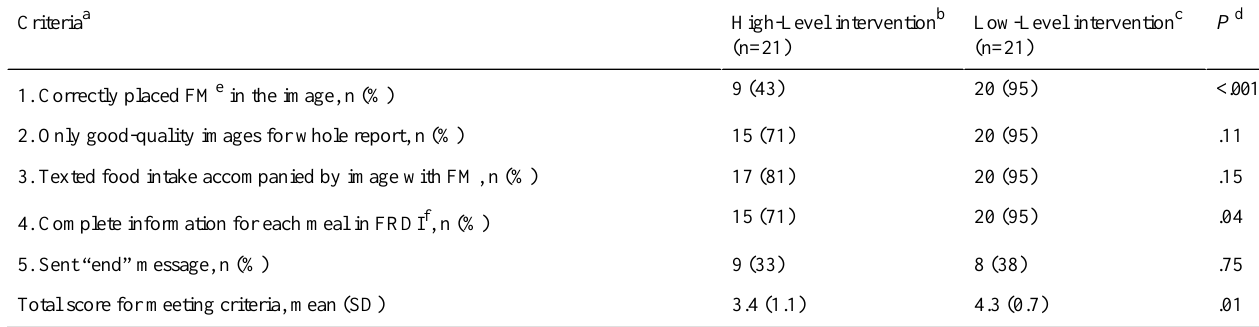
Table 3. Proportion of adolescents that met the requirements for food recording with digital images, by